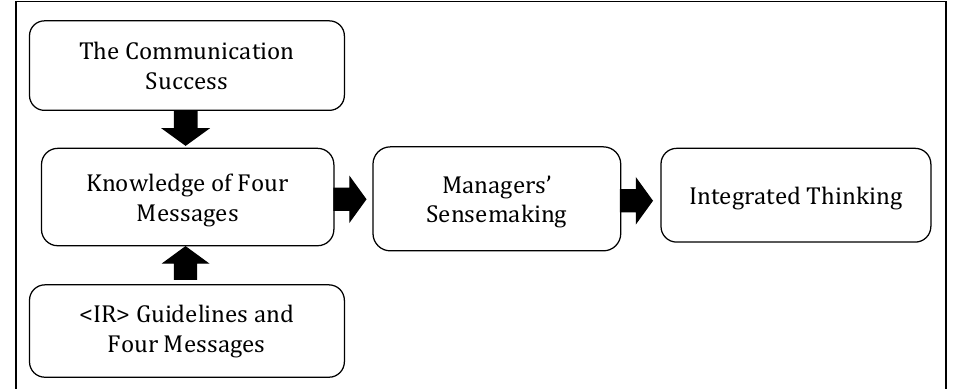
Figure 1: Conceptual